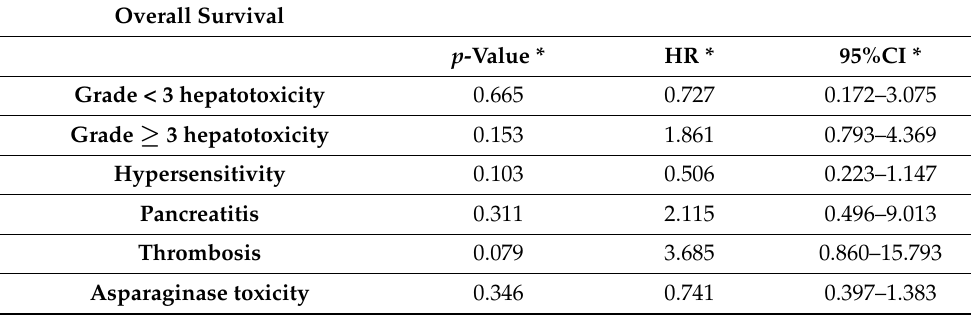
Table 8. Multivariate Cox regression analysis of patients with asparaginase toxicity